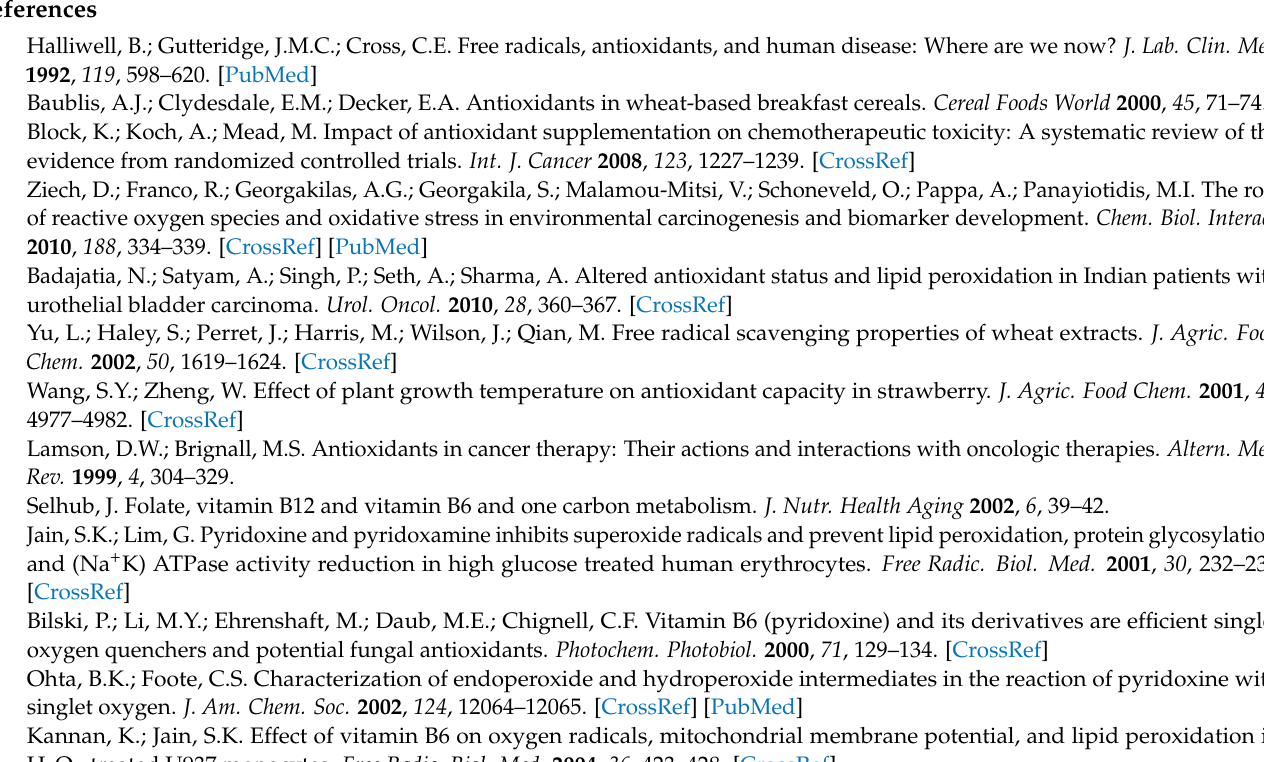
periment; Table S1: Experimental data and structure refinement for B6NO; Table S2: Hydrogen bonds for co-crystallizate B6NO; Table S3: Main bond lengths for B6NO; Figure S2: (a) IR spectrum of the compound I (2-(nitrooxy)butanedioic acid); (b) IR spectrum of the compound II (di(3-hydroxy-4,5- bis(hydroxymethyl)-2-methylpyridinium) 2-(nitrooxy)butanedioate) (KBr pellet); Figure S3: 1H NMR spectrum of compound I (2-(nitrooxy)butanedioic acid) (DMSO-d6); Figure S4: 1H NMR spectrum